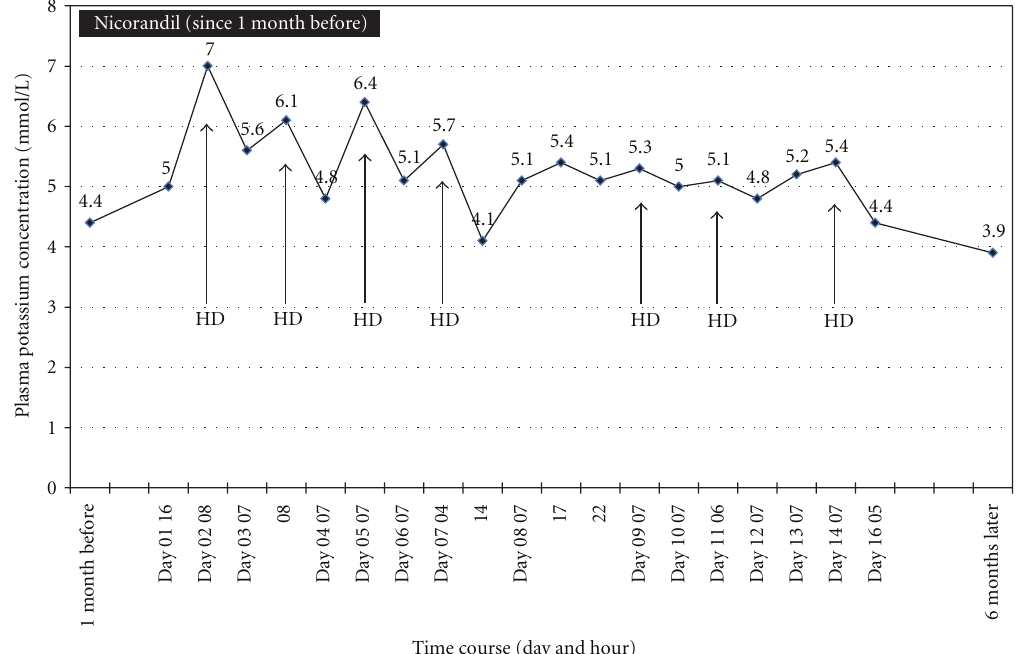
Figure 2: Recurrent hyperkalemia was found during nicorandil treatment. After cessation of nicorandil use, extreme hyperkalemia was not found again. HD (arrow):